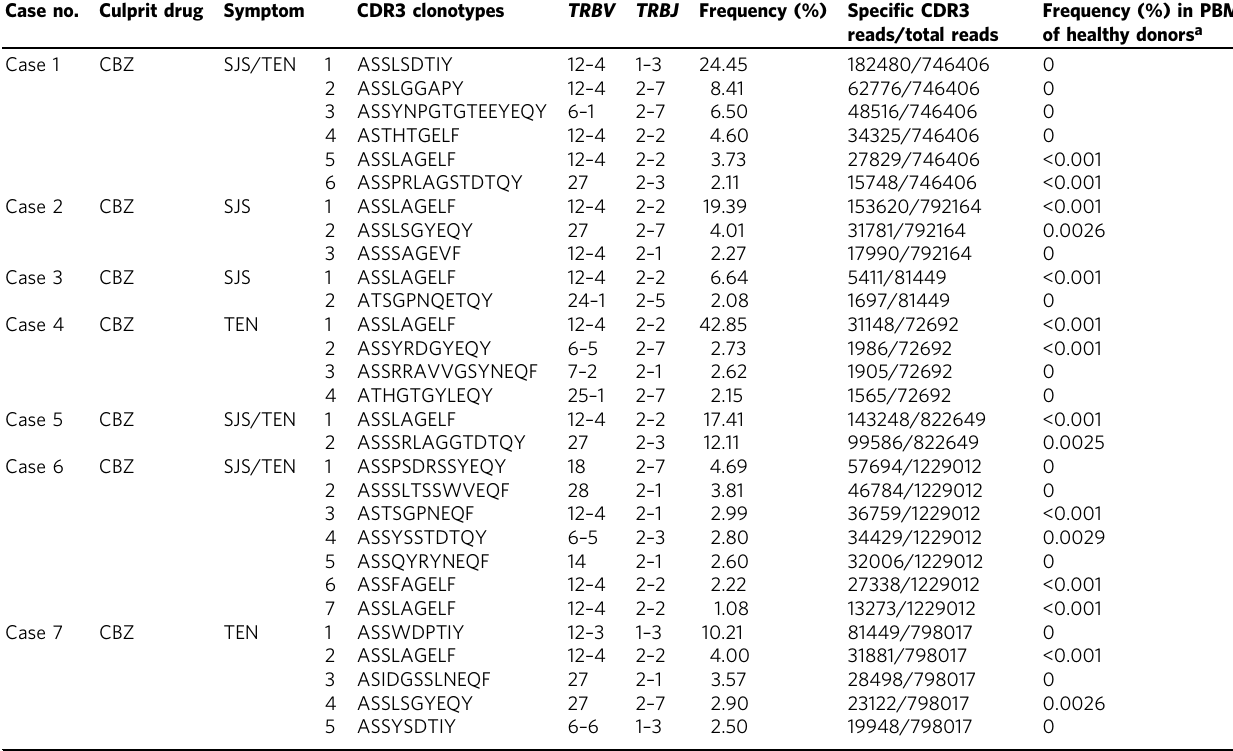
Table 1 Preferential TCR β CDR3 clonotypes in blister cells from patients with CBZ-SJS/TEN